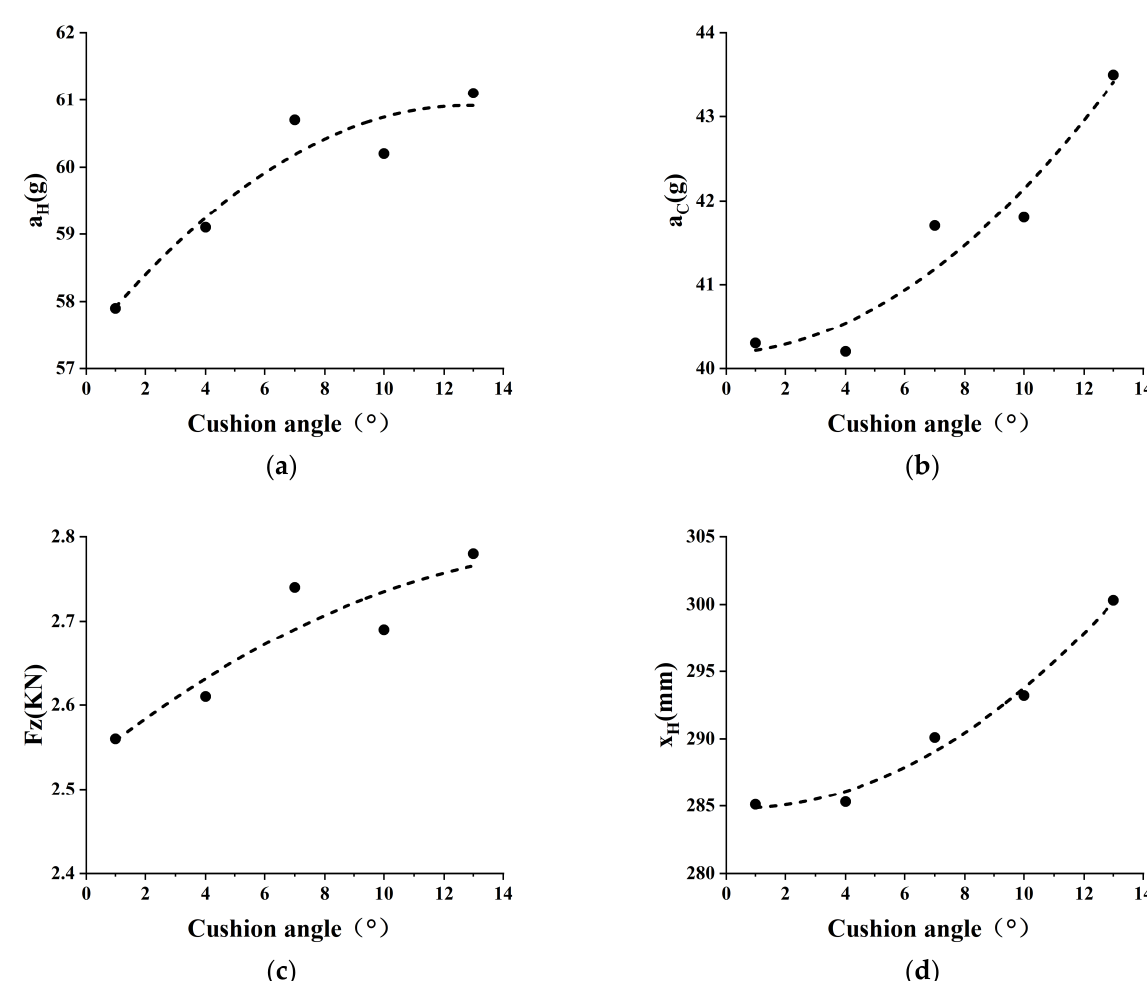
Figure 15. A value of 3 ms head resultant acceleration 𝑎 𝐻 variation ( a ), 3 ms chest resultant acceleration 𝑎 𝐶 variation ( b ), upper neck tension 𝐹 𝑍 variation ( c ), and the head horizontal displacement 𝑥 𝐻 variation ( d ) caused by the cushion angle adjustment.